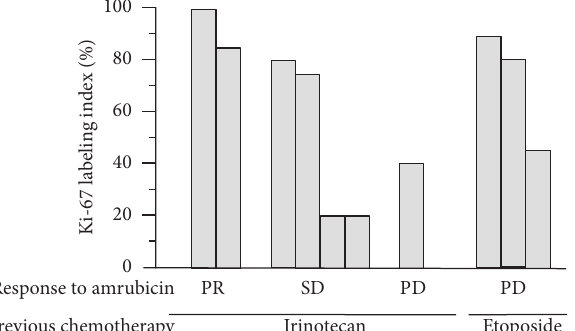
Figure 2: The association between response to amrubicin therapy and the Ki-67 index or previous